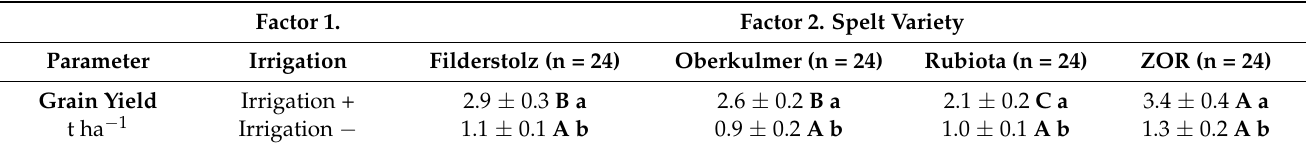
For each parameter assessed, means labelled with capital letter within the same row or the same lower-case letter within the same column are not significantly different (general linear hypothesis test p <